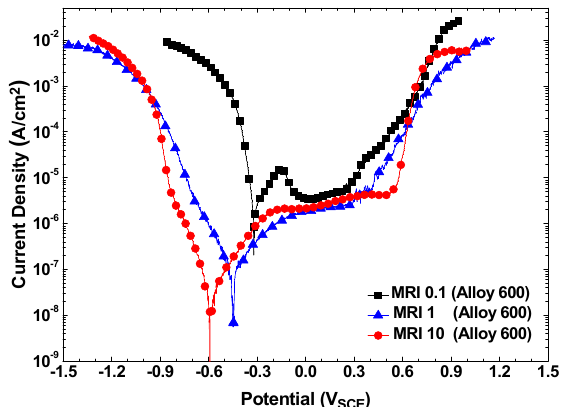
Figure 1. Polarization curves of Alloy 600 in the solutions of the MRI 0.1, 1 and 10 at a total sodium and chloride ion concentration of 0.011 M.